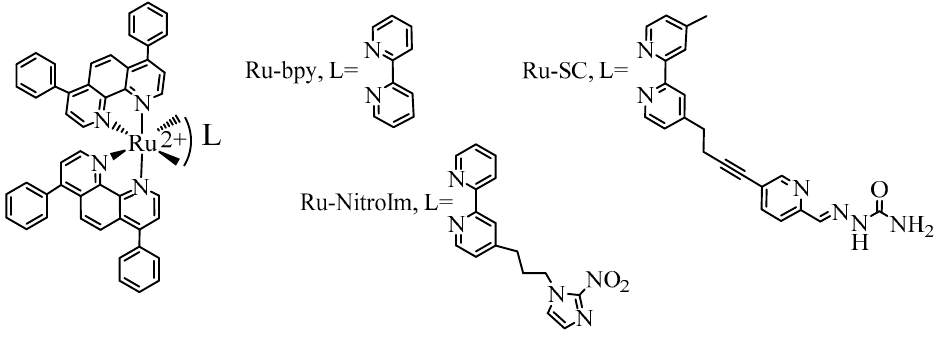
Figure 1. The studied ruthenium (II) polypyridyl complexes.